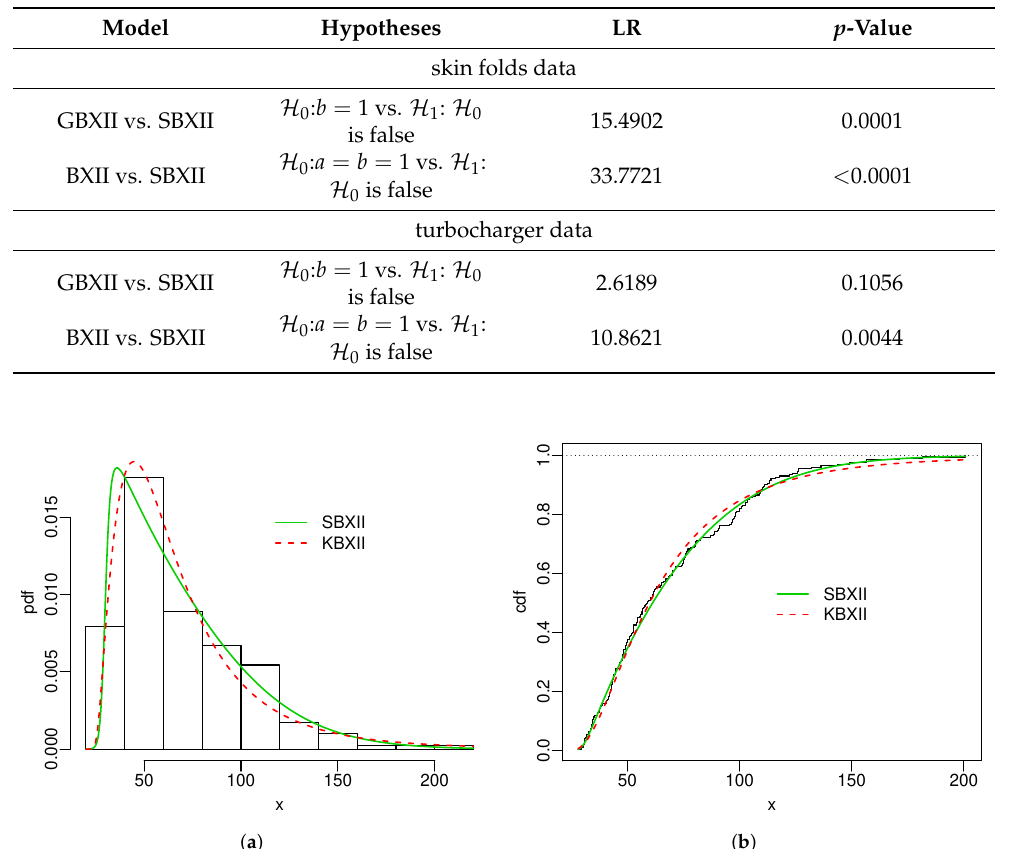
Table 5. LR tests for skin folds and turbocharger data.